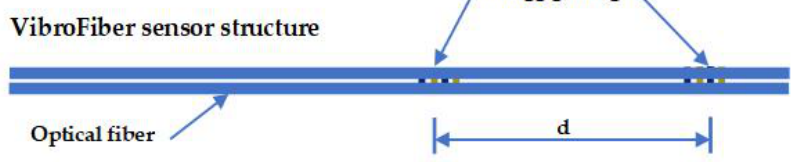
Figure 2. The designed sensor (30 mm × 14 mm × 2 mm).